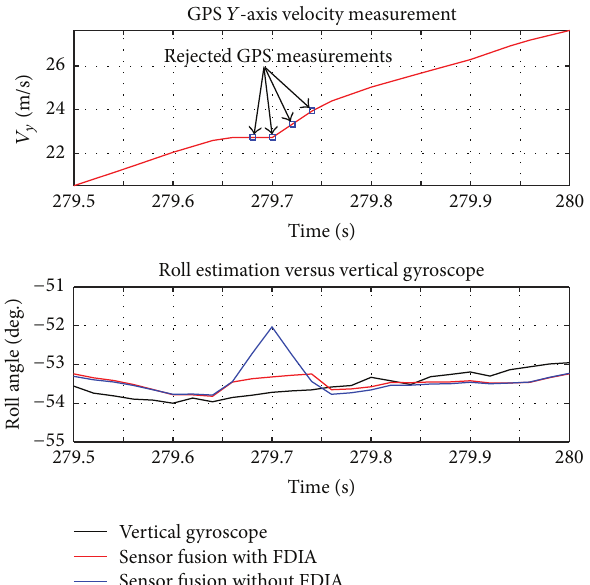
Figure 6: Sensor fusion with no failure, GPS failure, rate gyroscope failure, and magnetometer failure.